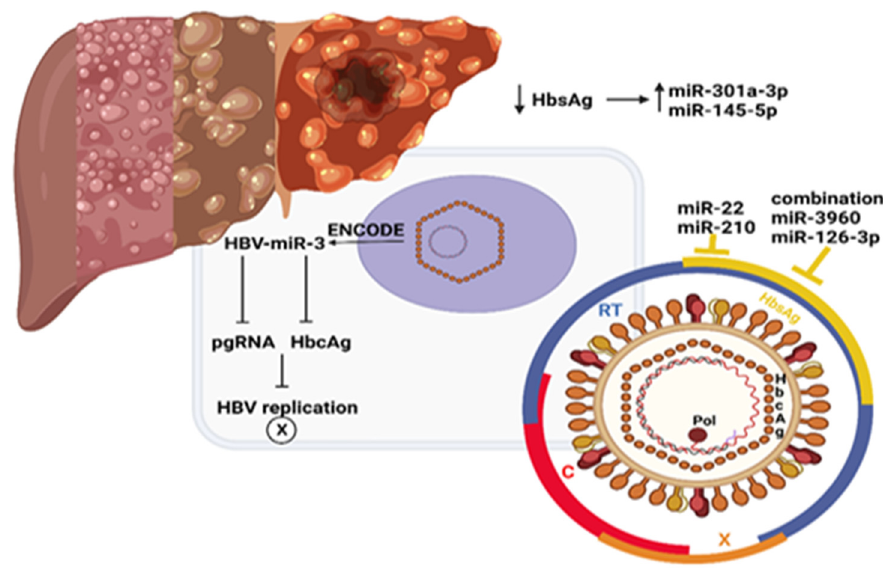
Figure 3. Antiviral HBV treatment influencing microRNAs.